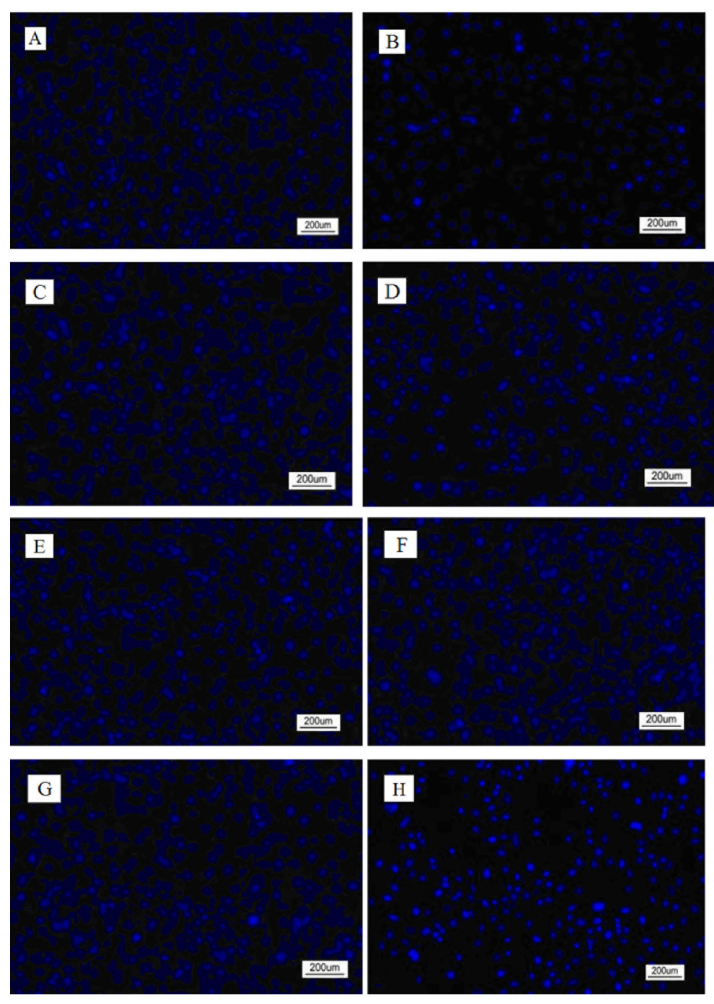
Figure 7. Fluorescent staining of Saos-2 cells after culture in the extracts of MAO-coated and uncoated magnesium for 72 h. Panels A-G show that the morphology of Saos-2 cells cultured in different extracts for 72 h was normal and healthy, similar to that of the negative control, but the 5% DMSO positive control revealed many apoptotic cells, manifested as nuclear pyknosis ( panel H ). A , Negative control; B , 100% Mg; C , 50% Mg; D , 25% Mg; E , 100% MAO-coated Mg; F , 50% MAO-coated Mg; G , 25% MAO-coated Mg; H , 5% DMSO positive control. MAO: micro- arc